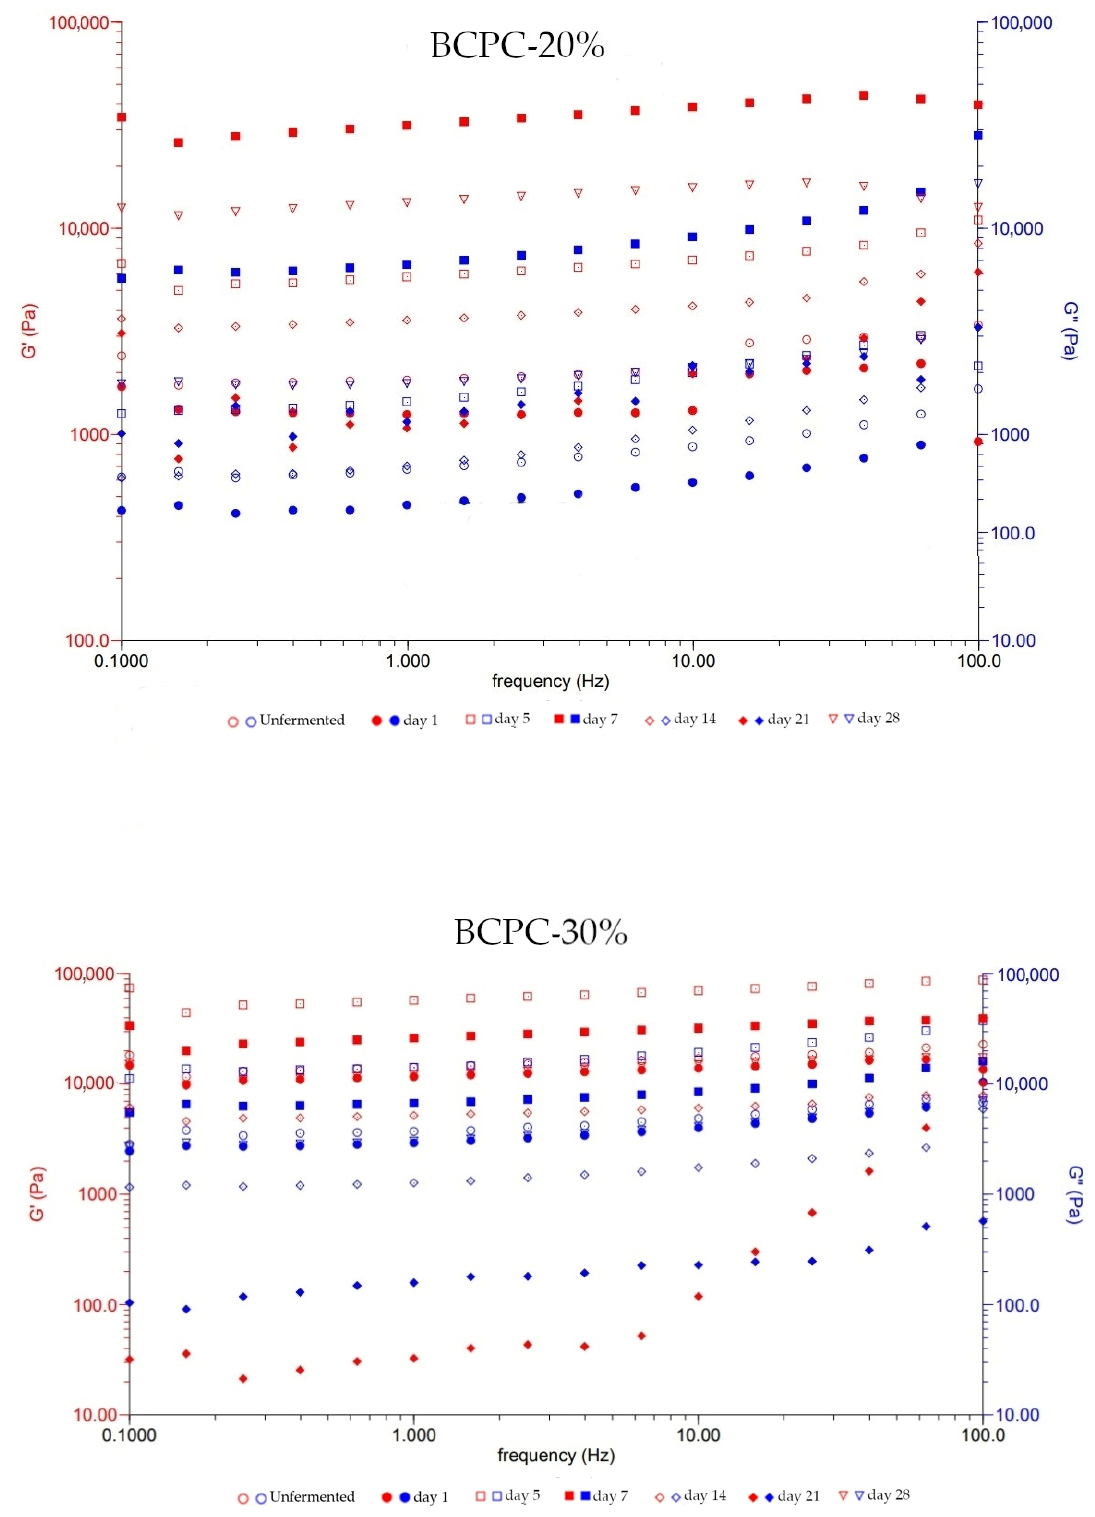
Figure 2. The changes of G’ (storage modulus) and G’’ (loss modulus) The textural changes during storage are presented in Table 5. The hardness, chewiness, and gumminess increased in both samples after fermentation ( p < 0.05). The chewiness and gumminess decreased after 7 days of storage ( p < 0.05). On days 0 and 1,